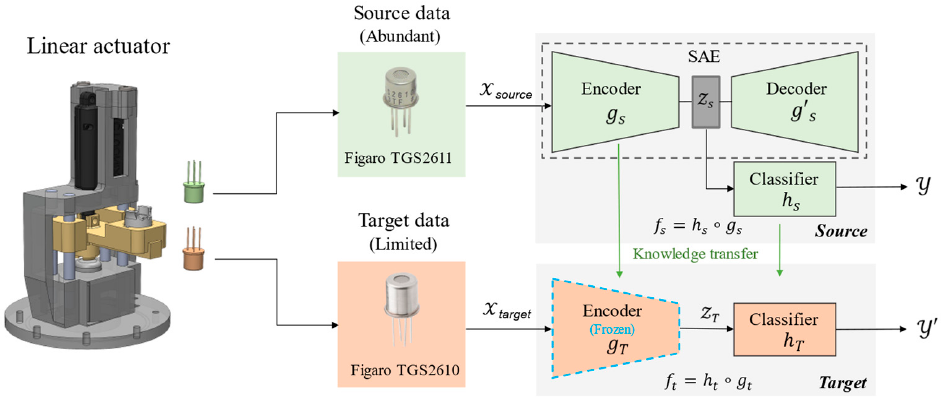
Figure 1. Schematic of the proposed SAE-TL framework.